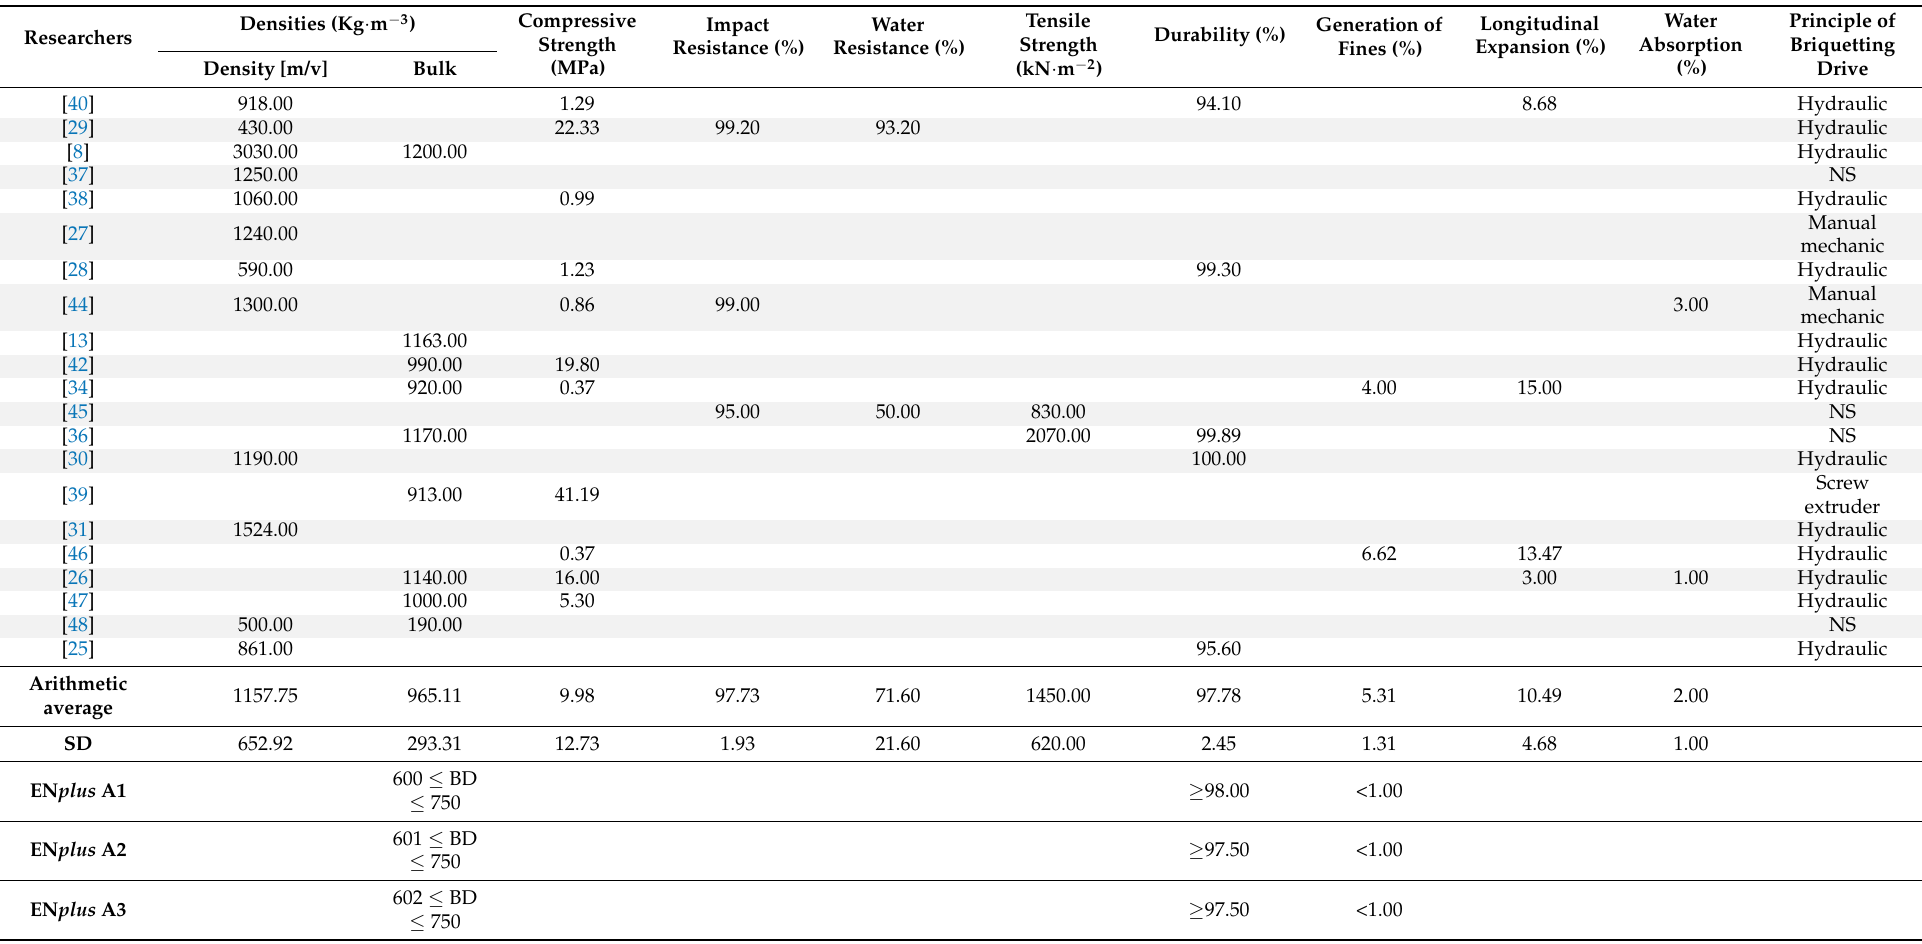
Table 11. Main physical-mechanical output variables to qualify the